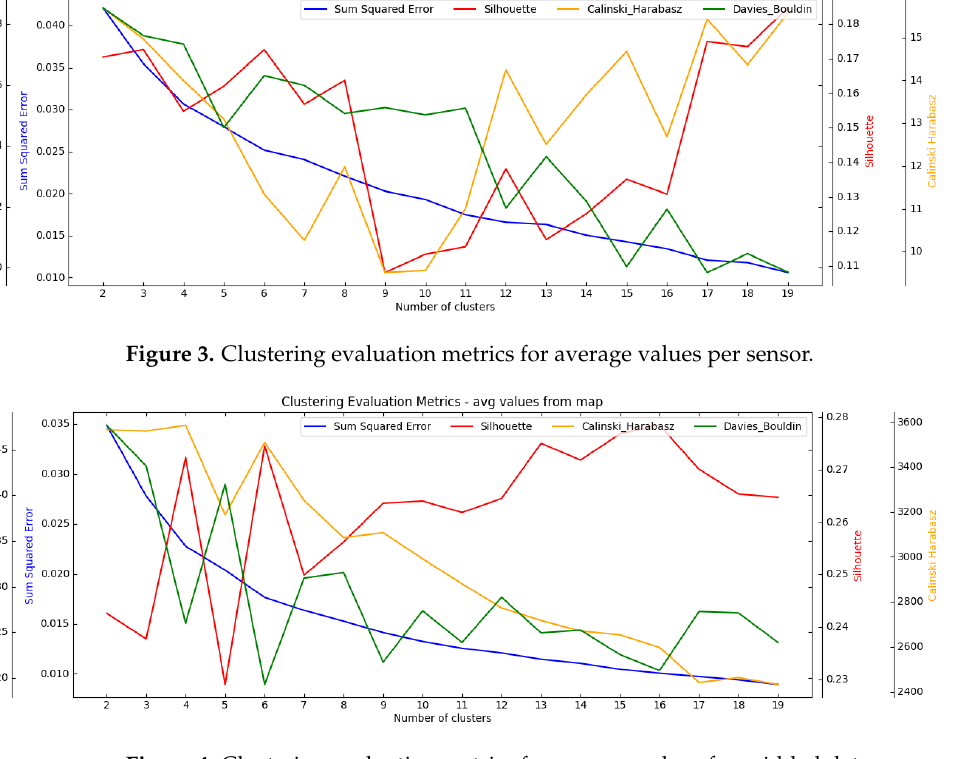
Figure 4. Clustering evaluation metrics for average values for gridded